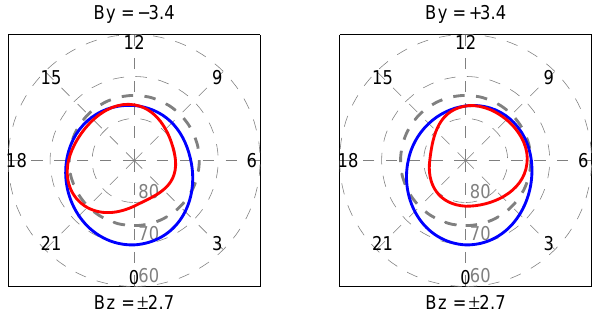
Fig. 5. Position of the polar cap boundary (in the MLT-MLat frame- work) according to the TS-2005 model for IMF B y = − 3 . 4nT and B y = + 3 . 4nT (left and right panel, respectively). Red and blue curve corresponds to B z > 0 and B z < 0, respectively. Dashed cir- cle indicates the position of